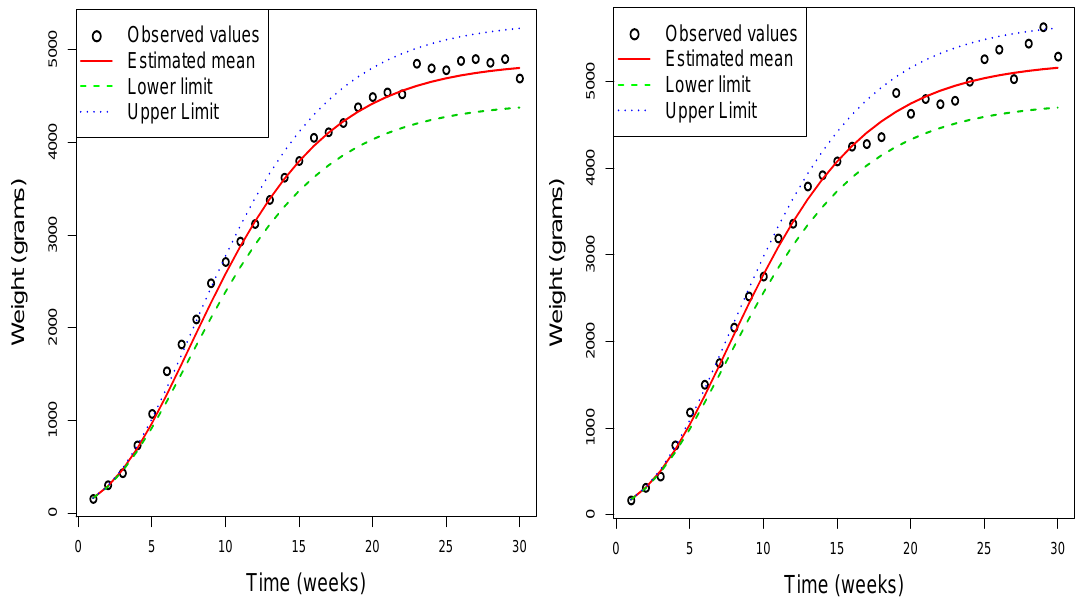
Figure 3. Observed values, estimated mean function, and confidence intervals for a choice of